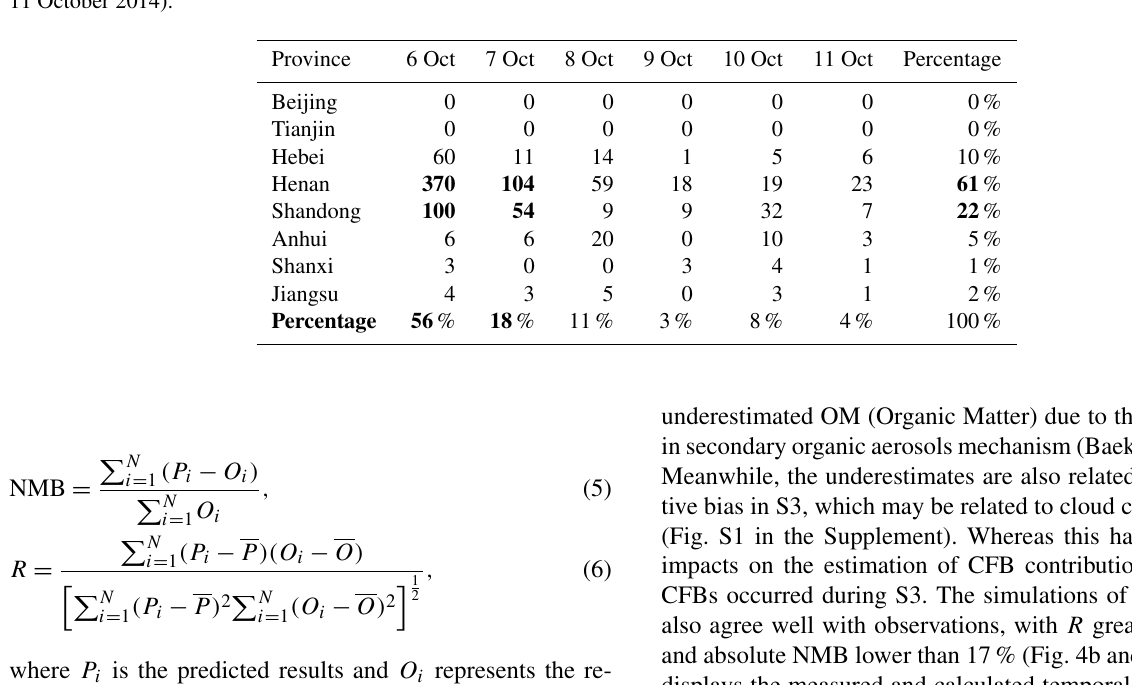
Table 3. The fire counts of crop field burning detected by the MODIS in the provinces over NCP during the haze episode (from 6 to 11 October